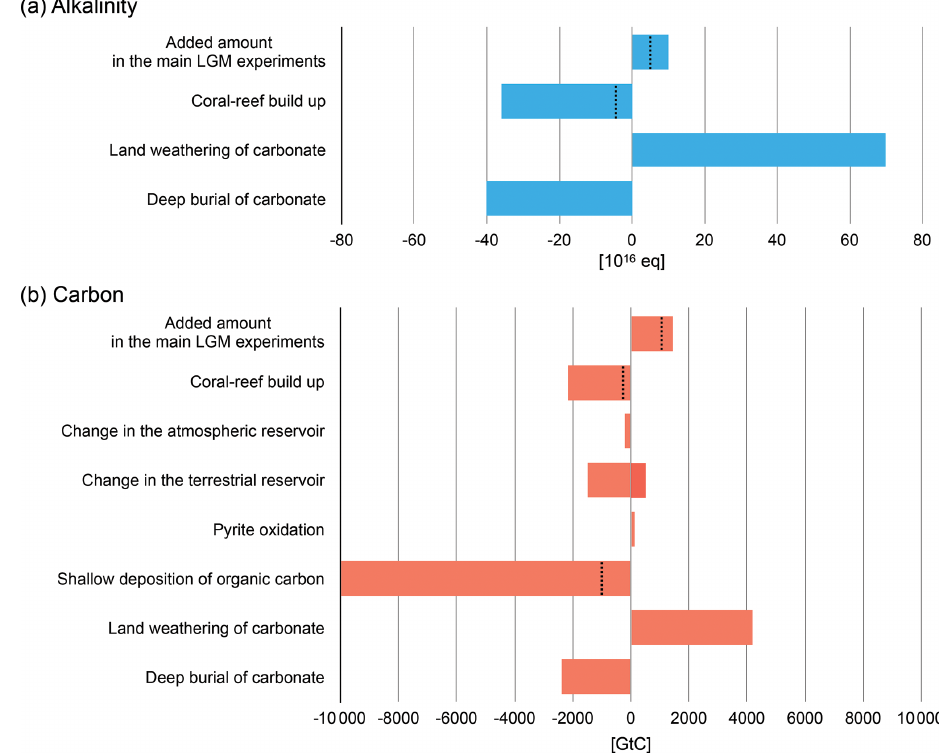
Figure 12. Processes discussed in Sect. 4.1 that contributed to the change in the ocean inventories of alkalinity (a) and carbon (b) since the LGM. Positive values indicate addition of alkalinity or carbon to the ocean and negative values removal of them. For the component “coral-reef build up”, the range of estimates by previous studies (Milliman, 1993; Opdyke, 2000; Ridgwell et al., 2003; Vecsei and Berger, 2004; Husson et al., 2018; Köhler and Munhoven, 2020) is shown. “Land weathering of carbonate”, “deep burial of carbonate”, and “shallow deposition of organic carbon” are based on the time-average fluxes estimated by Cartapanis et al. (2018). “Change in the atmospheric reservoir”, “change in the terrestrial reservoir”, and “pyrite oxidation” show the amount from ice-core records (Bereiter et al., 2015; Köhler et al., 2017), the range of estimates by previous studies (Kemppinen et al., 2019), and the estimate by Kölling et al. (2019), respectively. The dotted lines correspond to the lowest estimate for the respective